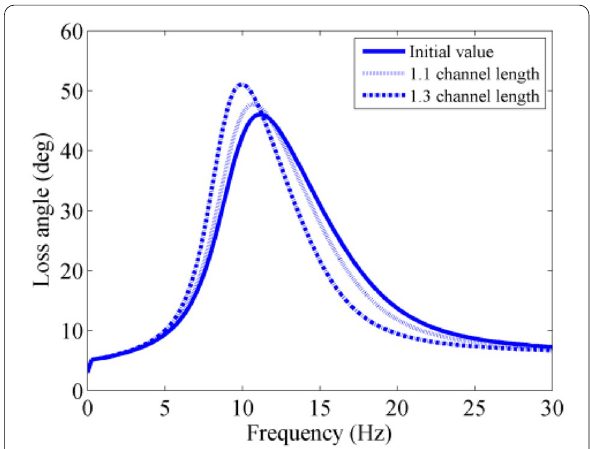
Figure 17 Loss angle vs. frequency curves for different volume compliances